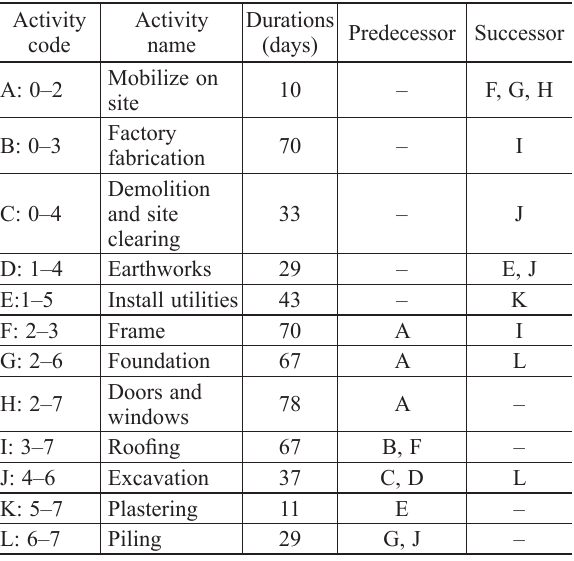
Table 3. Activities with precedence relationships and